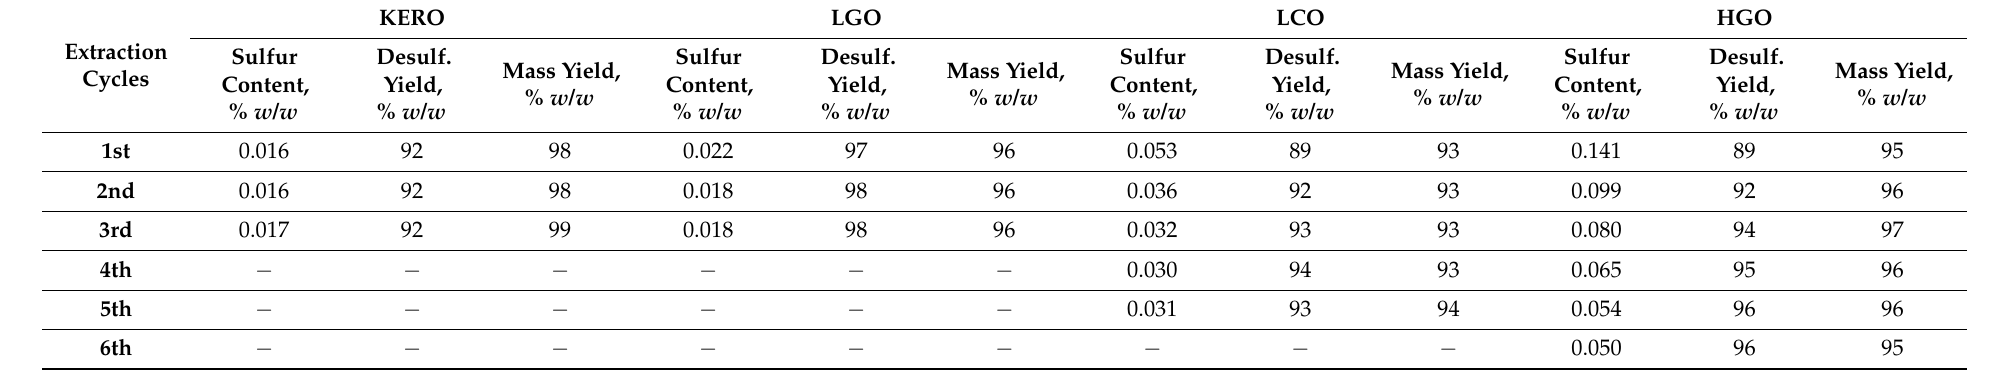
Table 12. Sulfur content, desulfurization yield and mass yield of the surrogate raffinates during the multiple-stage extractions with recycled [BMIM][HSO 4 ].